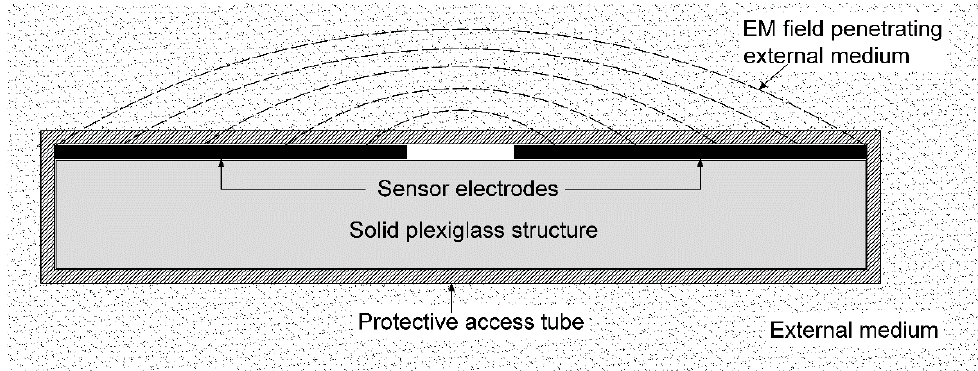
Figure 2. Cross section of sensor components and electromagnetic field generated between elec- trodes. The generated field generated between the two electrodes is expected to penetrate the exter- nal medium.